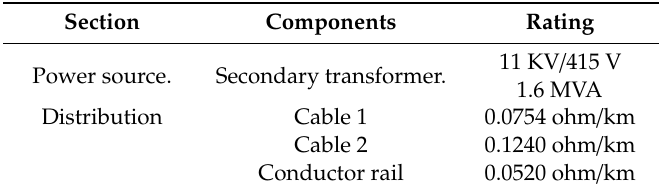
Table 2. Parameters of the cranes network [7].